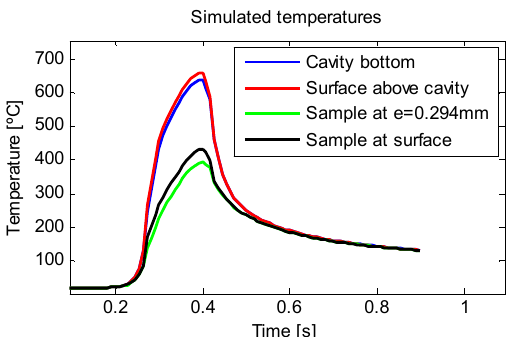
Figure 6. Simulated temperatures of different points of the model representing the temperature distortion caused by the cavity.